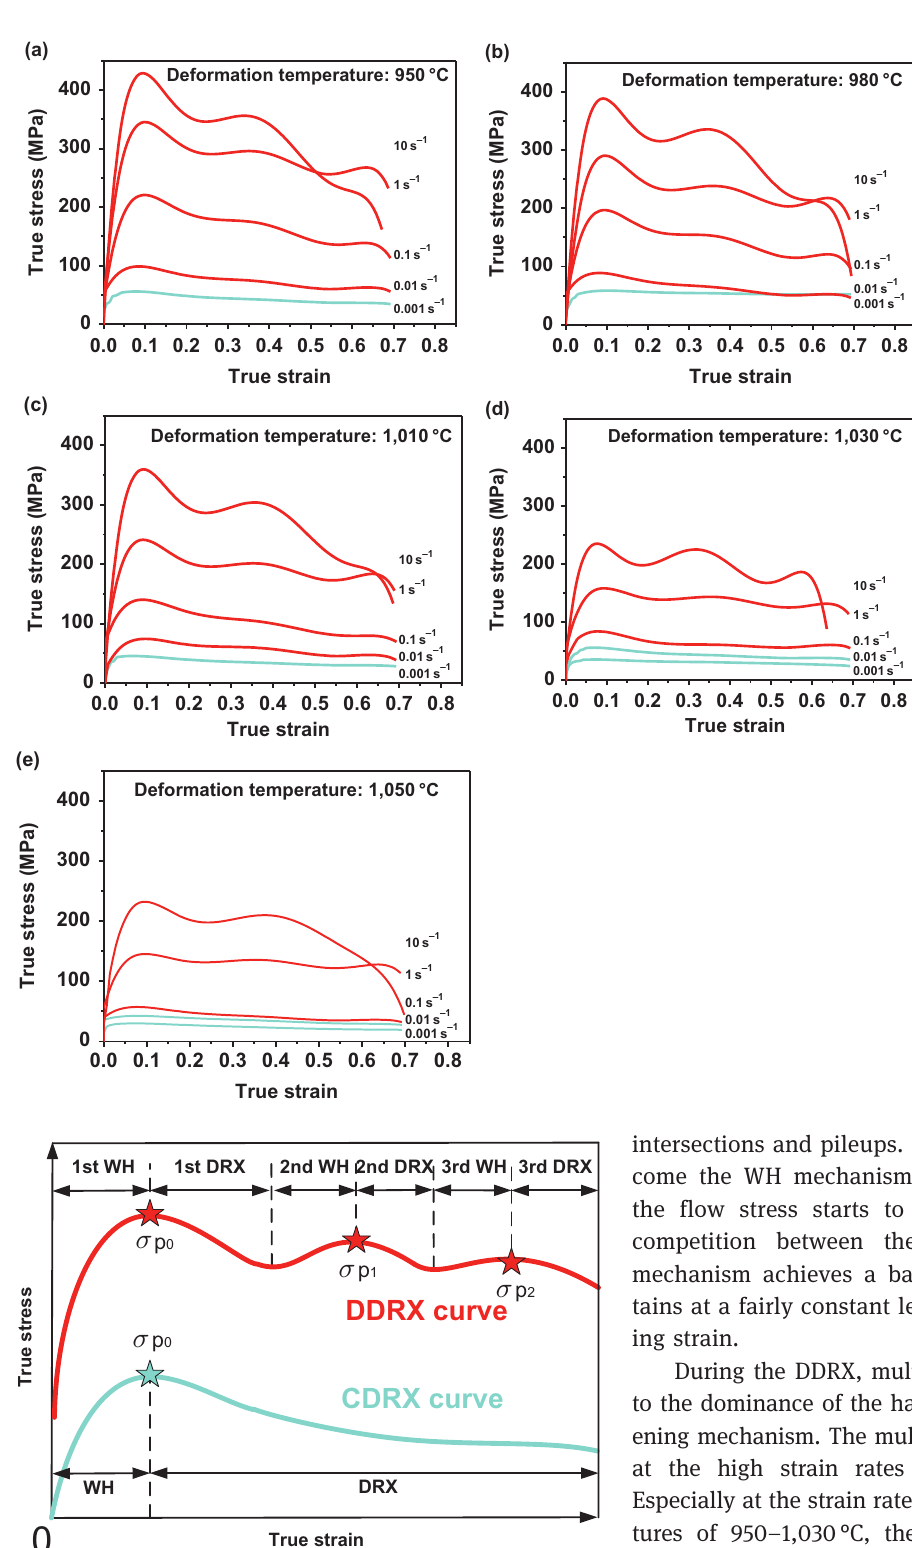
Figure 3: Schematic of the two types of flow curves, which indicates that the CDRX curve is of single peak and DDRX curve is of multi-